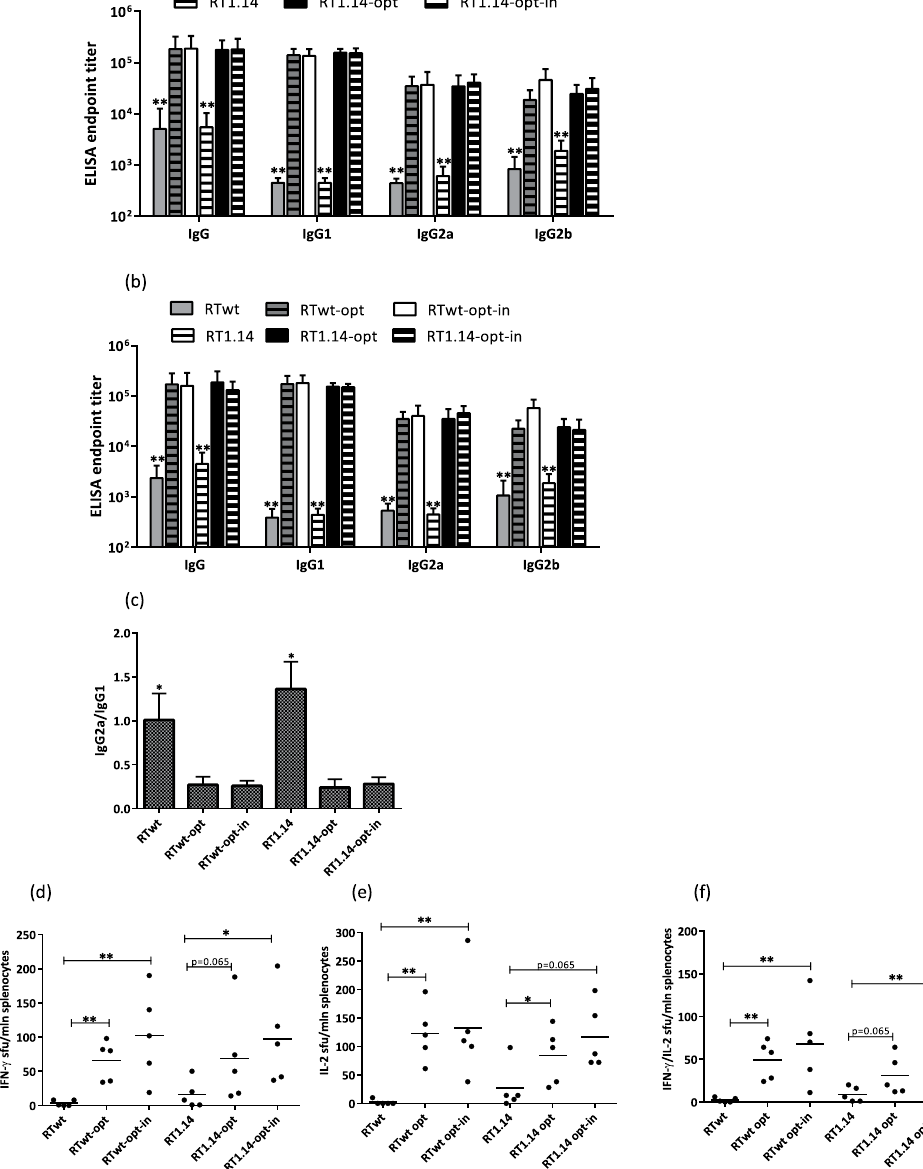
Figure 2. Immune responses following immunization with expression-optimized RT genes. BALB/c mice (n = 5 or 6) were immunized with two intradermal injections (29G needle) containing 20 µ g of RTwt, RTwt-opt, RTwt- opt-in, RT1.14, RT1.14-opt, or RT1.14-opt-in encoding plasmids per mouse with subsequent electroporation by Dermavax (standard protocol) in two independent immunizations. At 21 days post-immunization mice were sacrificed, and sera and splenocytes were isolated for further immune tests. End-point average titers of anti-RT total IgG and IgG subtypes were detected using ELISA against recombinant RTwt and RT1.14 proteins with cut-offs set against the serum reactivity of control mice immunized with vector pVax 1. ( a – c ) ELISA with the identical RT protein variant received as a gene, i.e. recombinant RTwt protein for RTwt, RTwt-opt, and RTwt- opt-in immunized mice or RT1.14 for RT1.14, RT1.14-opt, and RT1.14-opt-in immunized mice. ( a ) ELISA with the homologous RT, i.e. recombinant RT1.14 protein for RTwt, RTwt-opt, and RTwt-opt-in or RTwt protein for RT1.14, RT1.14-opt, and RT1.14-opt-in immunized mice. ( b ) IgG2a/IgG1 ratio for antibody reactivity against RT variants matching RT used as DNA immunogen ( c ). In panels (a,b) the asterisk designates the difference between RTwt and RTwt-opt/RTwt-opt-in and between RT1.14 and RT1.14-opt/RT1.14-opt-in variants for all IgG subtypes. Murine splenocytes were stimulated in vitro with an RT-derived peptide representing the epitope of RT aa 528–543 (immunodominant T-cell epitope; Table 2) in the IFN- γ /IL-2 Fluorospot test ( d – f ). The average number of cells was registered as signal-forming units (sfu) per million splenocytes secreting IFN- γ ( d ) IL-2 ( e ) and IFN- γ /IL-2 ( f ) and the error bars represent the SD. * p < 0.05; ** p < 0.01; tendency p-values are indicated on the graph. Statistical comparisons were performed using Kruskal-Wallis and Mann-Whitney